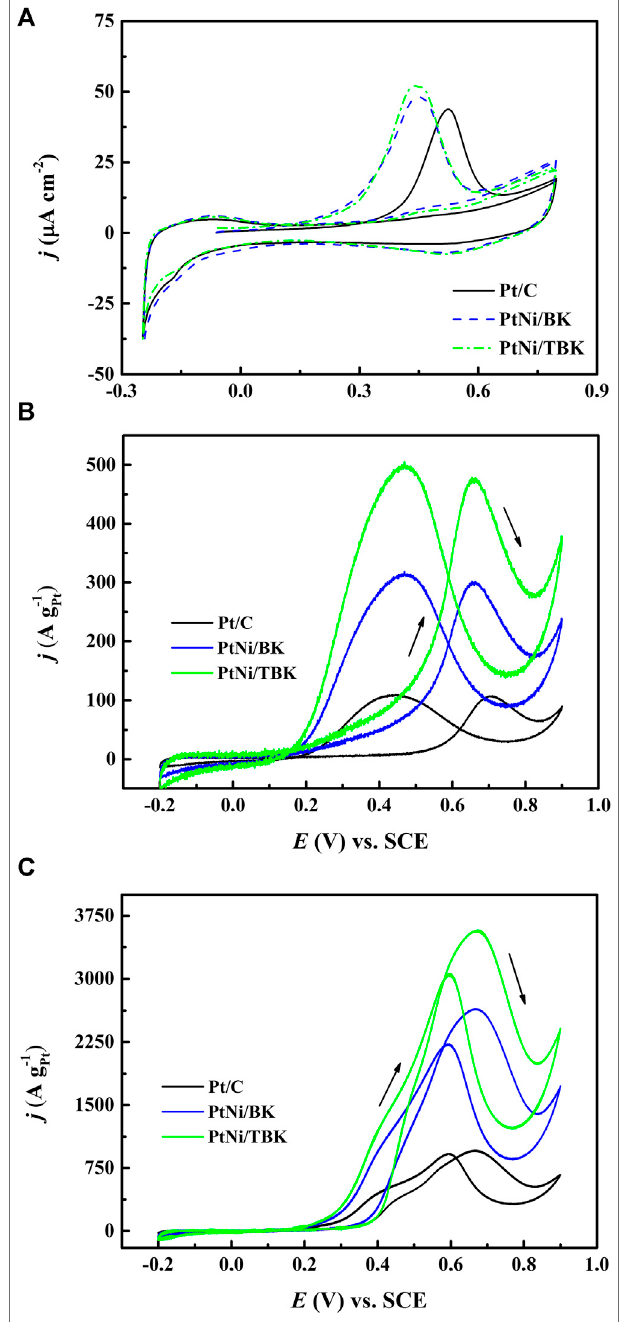
FIGURE5|(A) VoltammetricresponseforadsorbedCOstrippingonthe Pt/C, PtNi/BK and PtNi/TBK electrocatalysts in 0.1 M H 2 SO 4 at 20 mV s − 1 . Steady cyclic voltammograms (50th cycle) for the different electrodes in 1 M CH 3 CH 2 OH/0.5 M H 2 SO 4 at 25 ° C (B) and 60 ° C (C) .